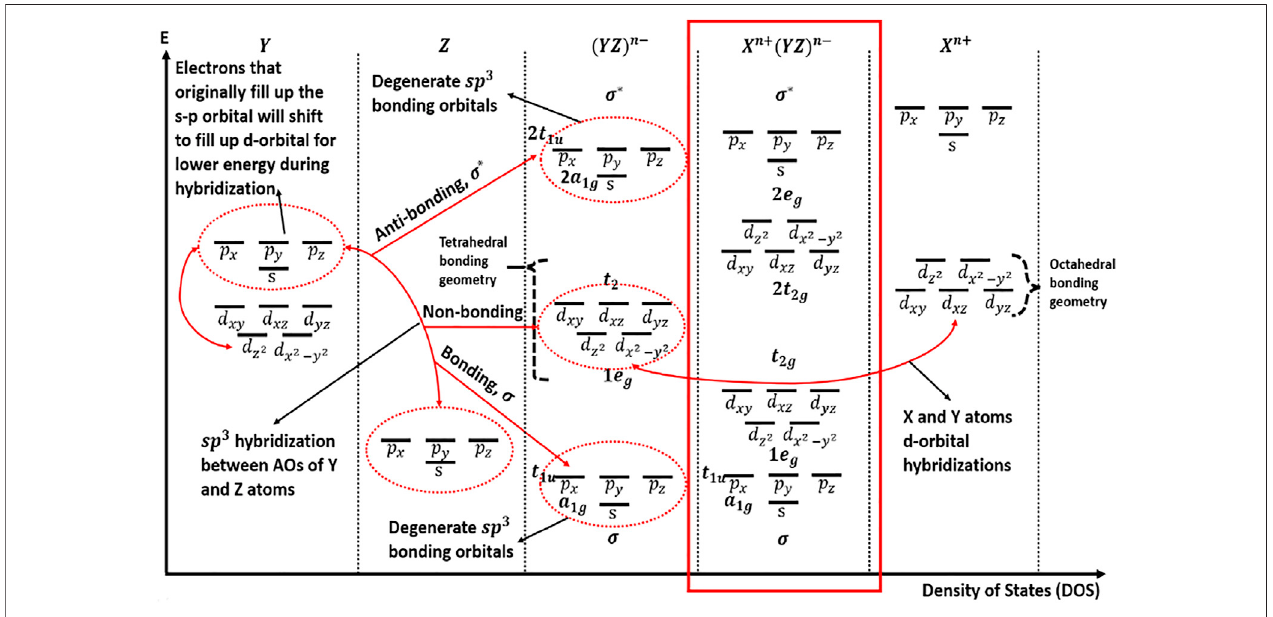
FIGURE 1 | MO and AO interactions of XYZ